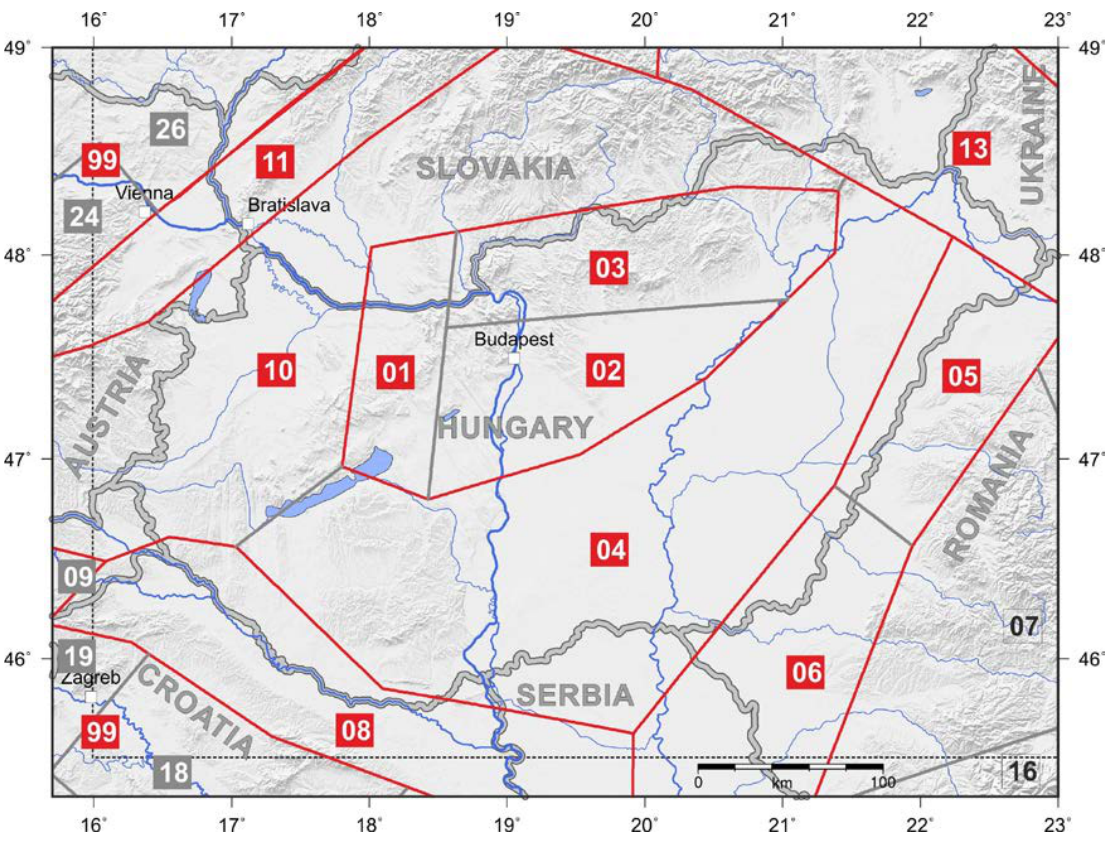
Figure 11. Source zones and zone groupings used in the model, based on the area sources of the SHARE project [26]. The core geographical window is also displayed—the downscaled model covers the part of the zones falling within the core window. Zones 01–02–03, Zones 04–10, and Zones 05–06 are grouped for the model. The non-contiguous zones with grey labels are grouped for the model as the residual Zone 99. Zones with empty labels are not modelled.